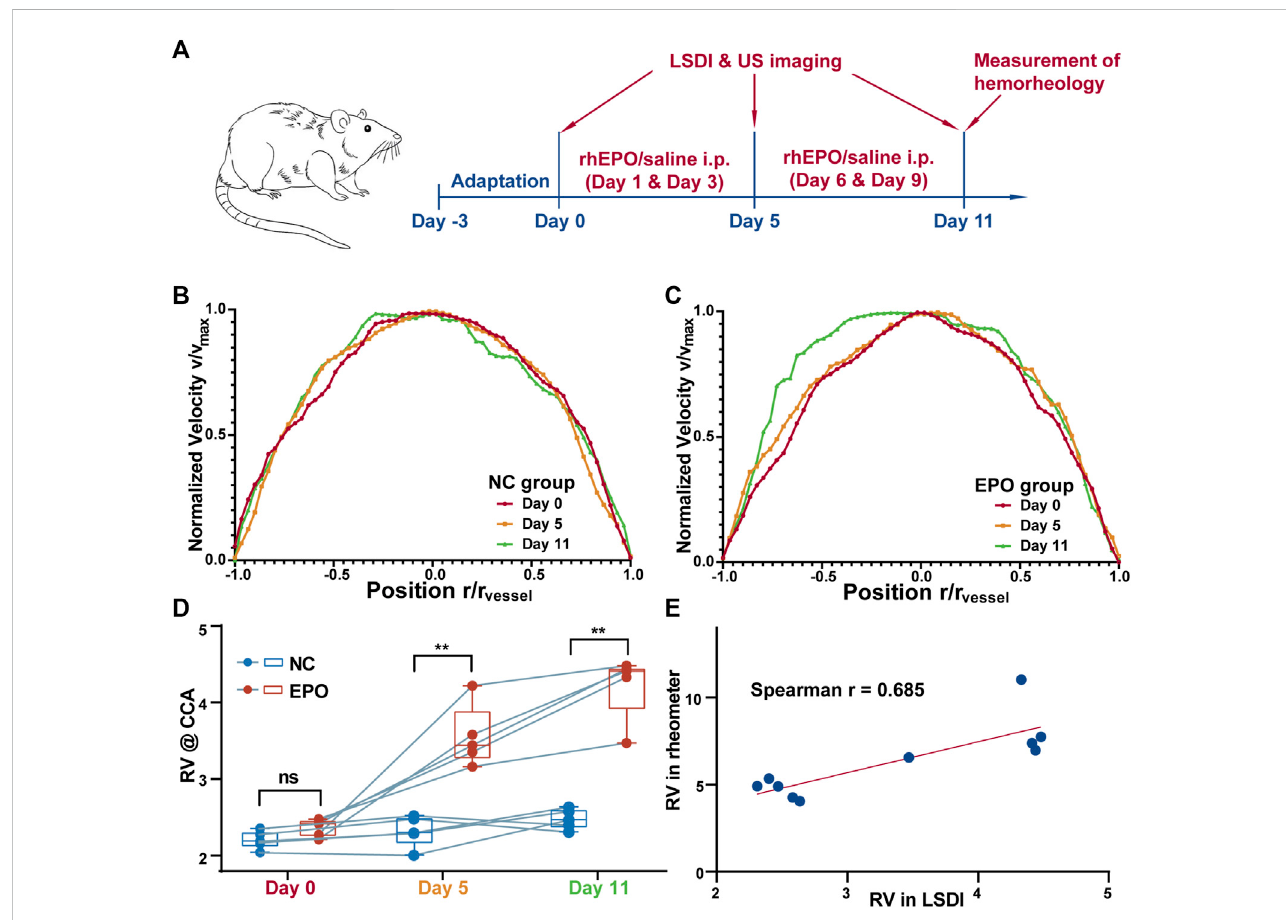
FIGURE 3 The timeline of the experiments (A) . Normalized blood fl ow velocity pro fi les (measured by LSDI) of control group (B) and EPO group (C) . The pro fi les of theEPO group showed obvious passivationon day11. The WBRV (measured by LSDI) of NCand EPO group ofanimals (D) . The WBRV in EPO group increased signi fi cantly (**: p < 0.01). The correlation between the WBRV of the two group measured by LSDI and rheometer on day 11 (E) . There is a strong correlation between the results measured by two methods. (Spearman r = 0.685, p < 0.05).